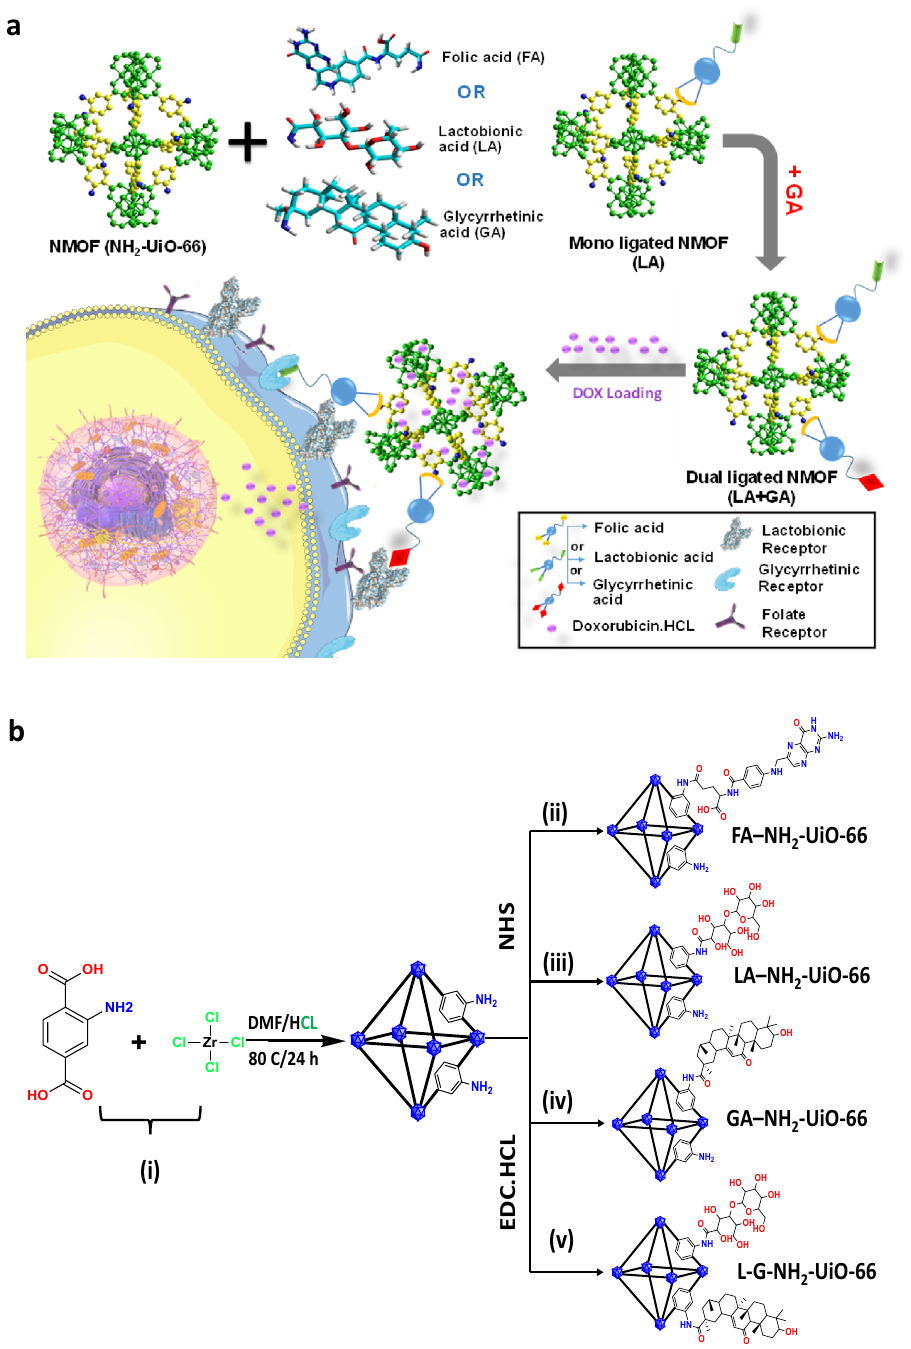
Figure 1. ( a ) Systematic representation of the functionalized Zr-based NMFOs (NH 2 -UiO-66) drug delivery carriers for targeted treatment of hepatocellular carcinoma. ( b ) The chemical synthesis scheme of mono- and dual ligated NH 2 -UiO-66. ( a ) was generated with HyperChem professional version 8.0.8 (http:// www. hyper cubeu sa. com/), and ( b ) was generated with ChemDraw Professional version 18.1 (https:// perki nelme rinfo rmati cs.